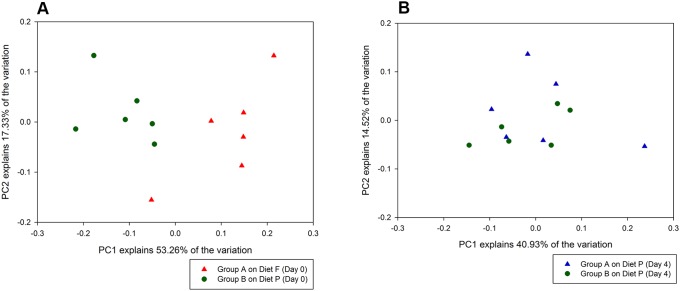
Principal coordinate analysis (PCoA) of bacterial communities detected in equine faeces pre- and post-dietary change based on the Bray-Curtis dissimilarity metric.(A) PCoA plot of faecal bacterial communities for Group A (Diet F) and Group B (Diet P) horses illustrates clustering of horses by dietary treatment group at Day 0. (B) PCoA plot of faecal bacterial communities for Group A (transition from diet F to diet P) and Group B (Diet P) horses illustrates no clustering by dietary treatment group at four days post-dietary change. Explanations for the symbols used are given in the legend.